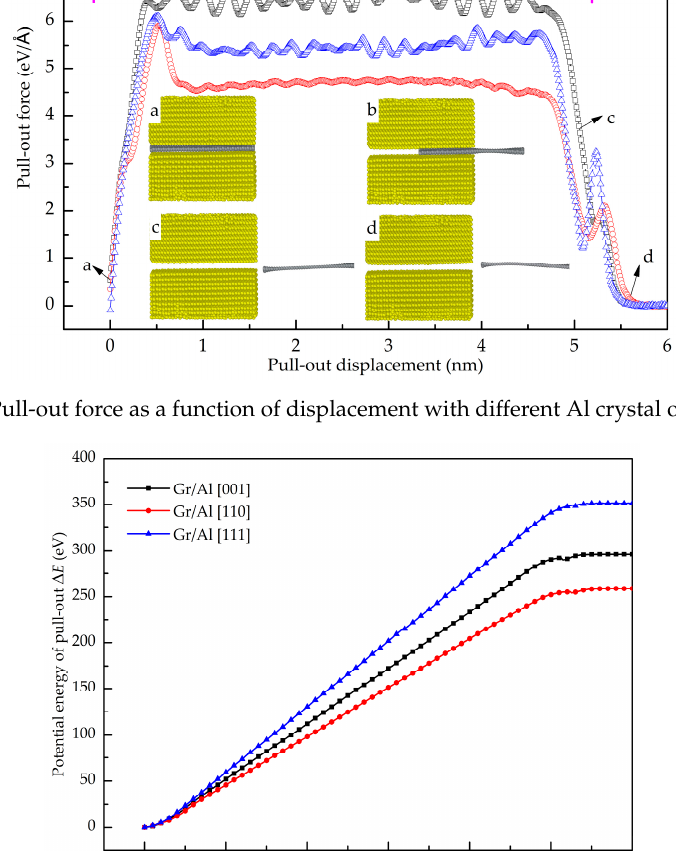
Figure 9. Variation of the potential energy of every part during pull-up process, the inset figure is the segmentation of graphene sheet at the non-loaded end (except for the red part) in pull-up test and the schematic diagram of load transfer at the interface. The temperature effect on the shear interfacial behavior is investigated here. Figure 10 shows the pull-out force as a function of pull-out displacement at different temperatures. It is found that the value of the stable pull-out force decreases with the increase of the temperature from 200 K to 500 K. When the temperature is lower than 200 K, the peak pull-out force varies little. Figure 11 shows the potential energy increment during the pull-out simulation at different temperatures, and the calculated interfacial shear strength is shown in Figure 12. It is seen that the shear interfacial strength keeps unchanged below 200 K with a value of 423 MPa. As the temperature rises from 200 K, the interfacial shear strength decreases. At the elevated temperature above 300 K, a slight drop of the